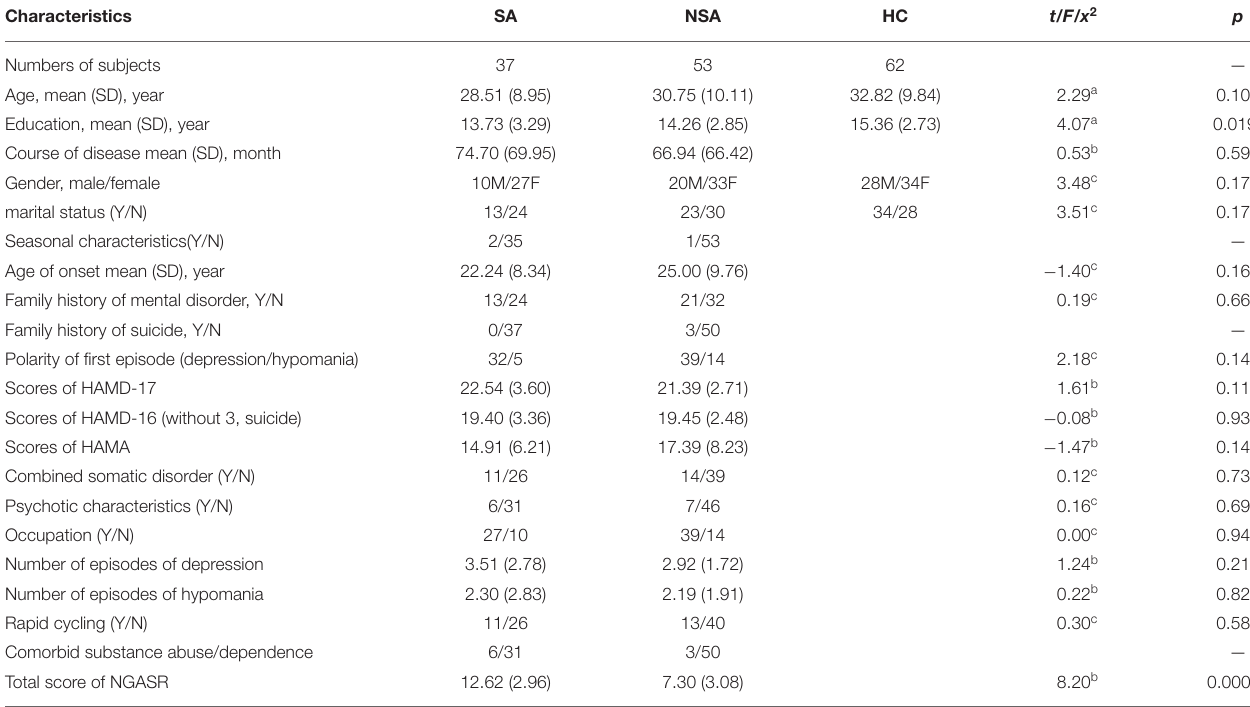
TABLE 1 | Demographic and clinical characteristics of